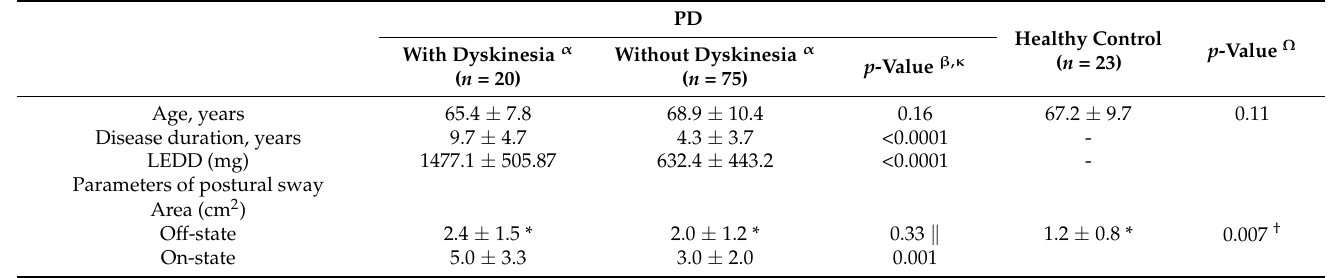
Table 2. The parameters of standing postural sway, UPDRS, and Tinetti total score between patients with and without dyskinesia before and after dopaminergic